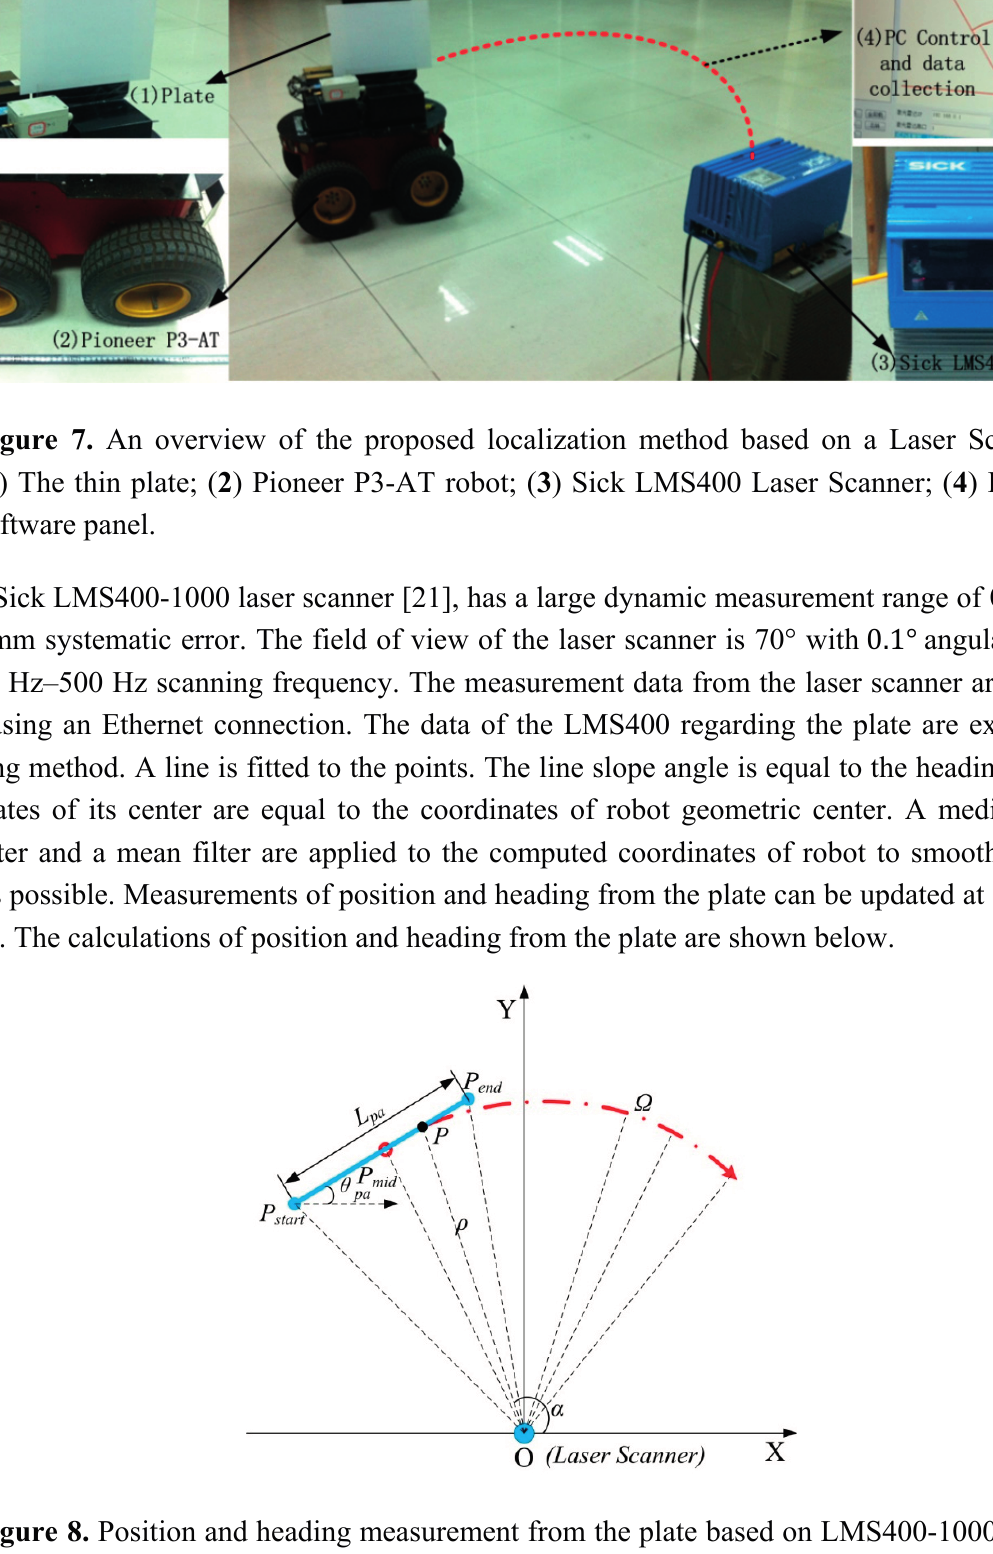
Figure 8. Position and heading measurement from the plate based on LMS400-1000 Laser Scanner for a real trajectory Ω of the robot’s